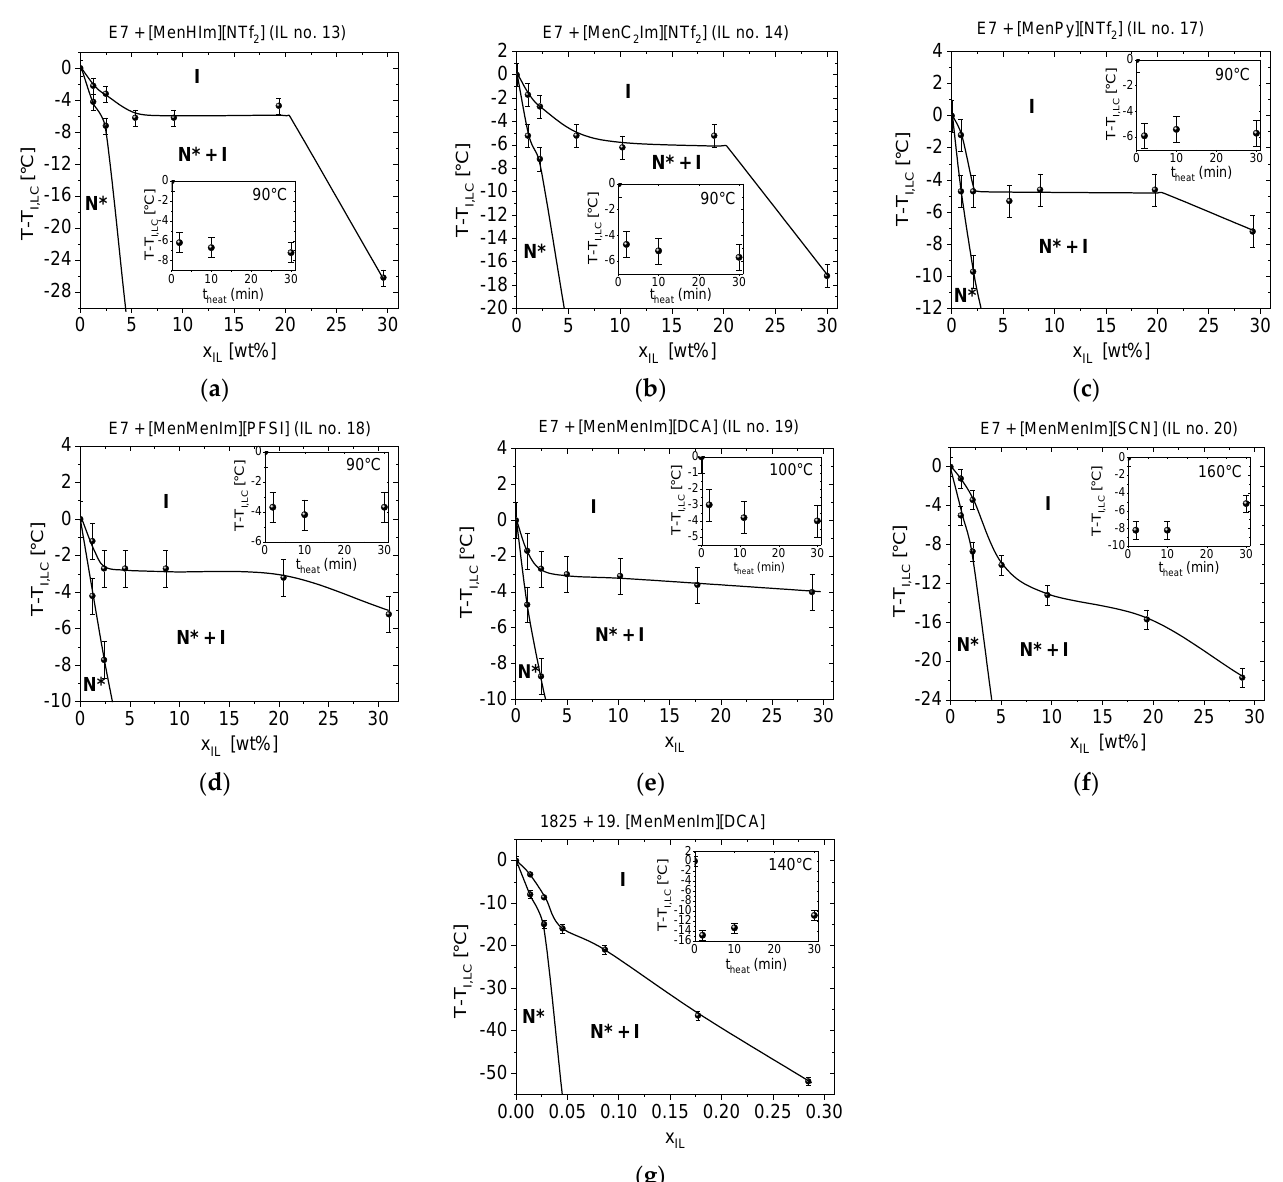
Figure 5. Phase diagrams of chosen LCs , with CILs mixtures exhibiting twisted nematic phase, determined just after preparation of the mixtures, in a range of IL weight fraction (x IL ) from 0 to 30%: ( a ) E7 + [ MenHIm ][ NTf 2 ], ( b ) E7 + [ MenC 2 Im ][ NTf 2 ], ( c ) E7 + [ MenPy ][ NTf 2 ], ( d ) E7 + [ MenMenIm ][ PFSI ], ( e ) E7 + [ MenMenIm ][ DCA ], ( f ) E7 + [ MenMenIm ][ SCN ], ( g ) 1825 + [ MenMenIm ][ DCA ]. Symbols: N* - twisted nematic phase, I – isotropic phase. The insets show the progress of the |ΔT NI | of the about 5 wt% mixtures with the heating time. The phase transition lines in the phase diagrams were sketched with respect to the determined points and serves for guiding an eye. Details are described in the